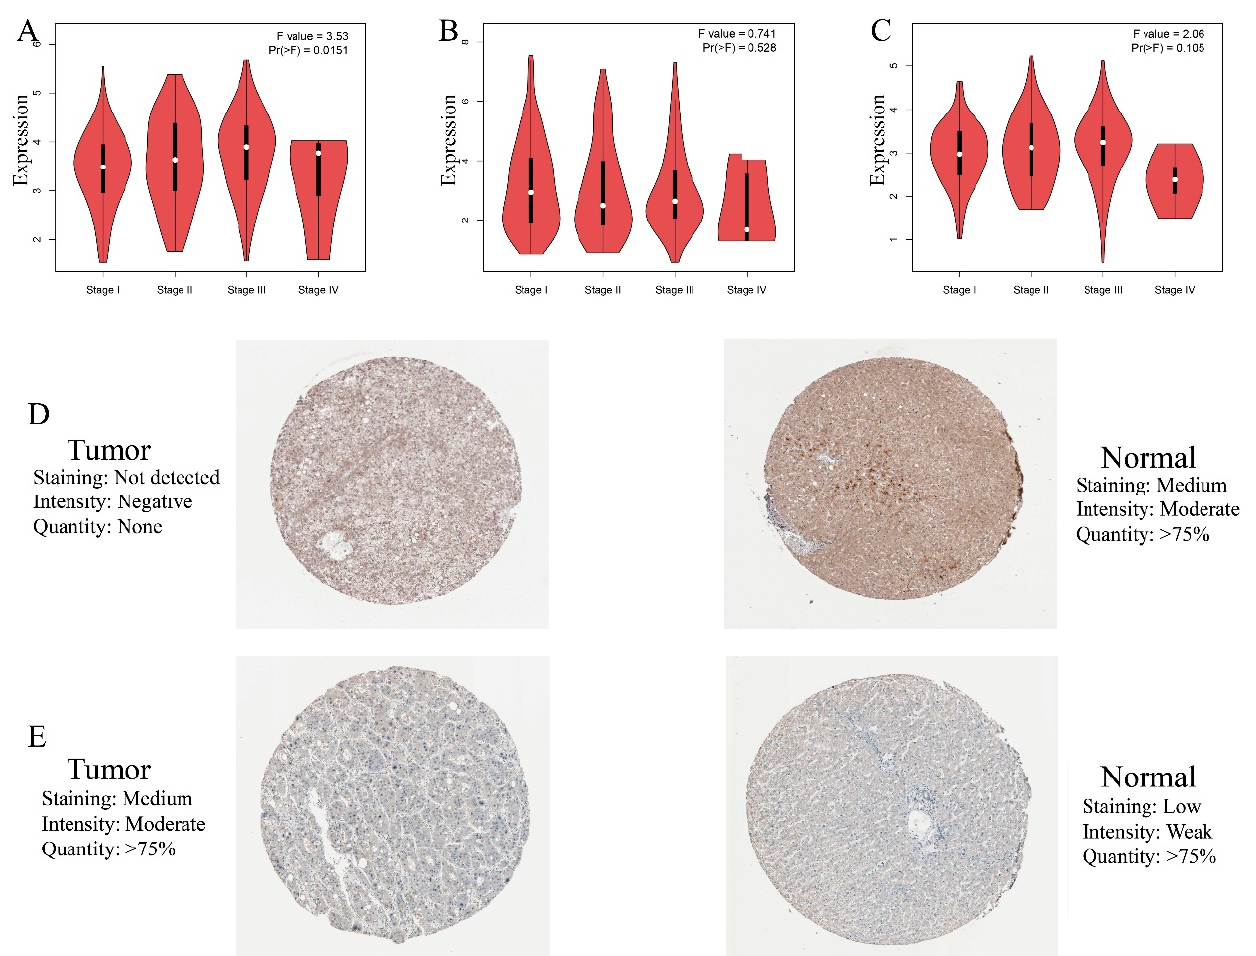
Figure 4. HDM gene expression in HCC versus normal tissues. ( A ) KDM5C. ( B ) KDM6B. ( C ) KDM8. ( D ) KDM4A. ( E ) JMJD7. * Implies statistically significant difference. Abbreviations: HCC, hepato- cellular carcinoma; LIHC, liver hepatocellular carcinoma. An asterisk indicates that the p -value of <0.05.